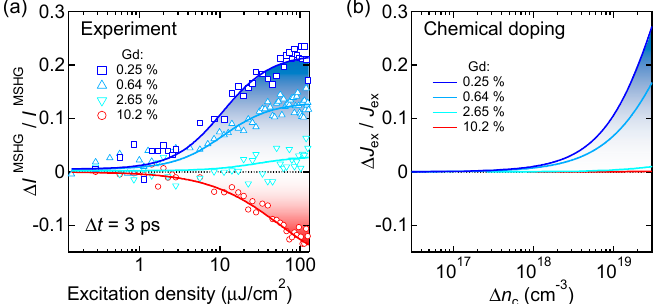
Figure 8. Continuous optical tuning of the exchange interaction J ex in ferromagnetic semiconductor Eu 1 − x Gd x O. ( a ) Excitation density dependence of the change of the MSHG intensity at ∆ t = 3 ps and at 10 K for selected Gd concentrations. Solid lines are guides to the eyes. ( b ) Calculated result of the ∆𝑛 (cid:2913) dependence of ∆𝐽 (cid:2915)(cid:2934) /𝐽 (cid:2915)(cid:2934) . Here, ∆𝐽 (cid:2915)(cid:2934) /𝐽 (cid:2915)(cid:2934) was calculated using the curve in Figure 3b, assuming that J ex is simply proportional to T C ( ∆ J ex / J ex = ∆ T C / T C ).